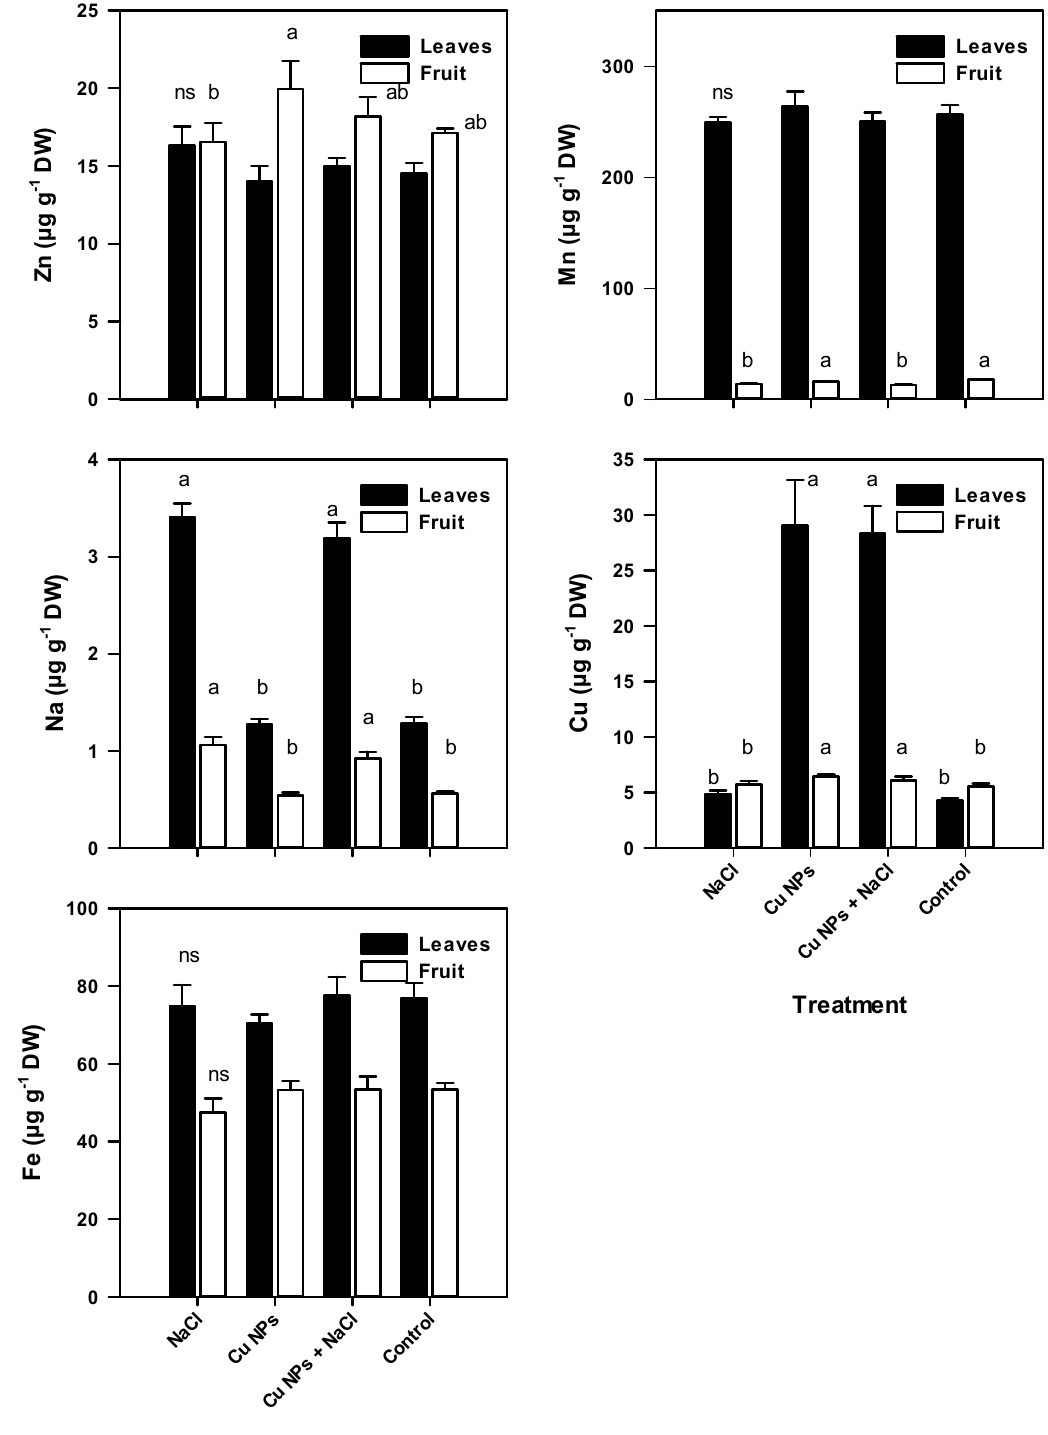
Figure 2. Micronutrient content in leaves and fruits of tomato plants under saline stress and foliar application of Cu NPs. All data are the mean of six replicates ± standard error. Di ff erent letters indicate significant di ff erences between treatments according to Fisher’s Least Significant Di ff erence ( p ≤ 0.05); ns—not significant.